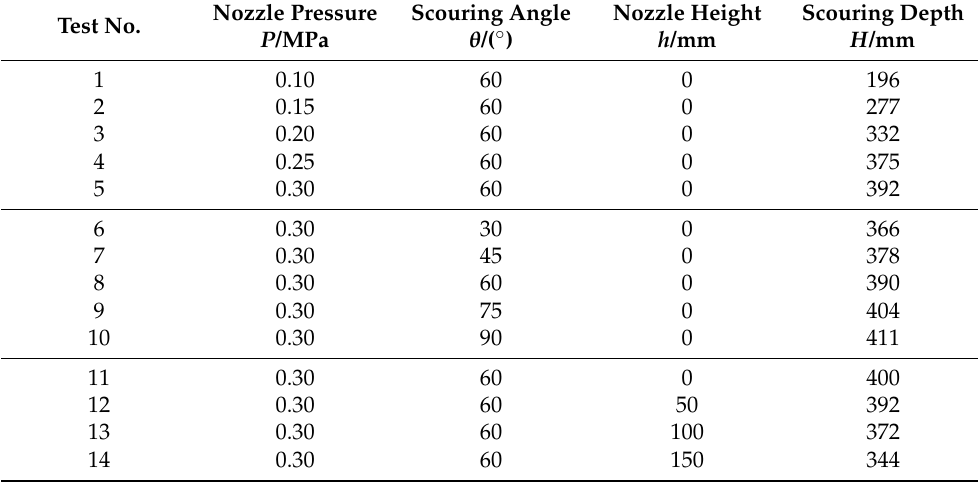
Table 8. Single-factor test plan and